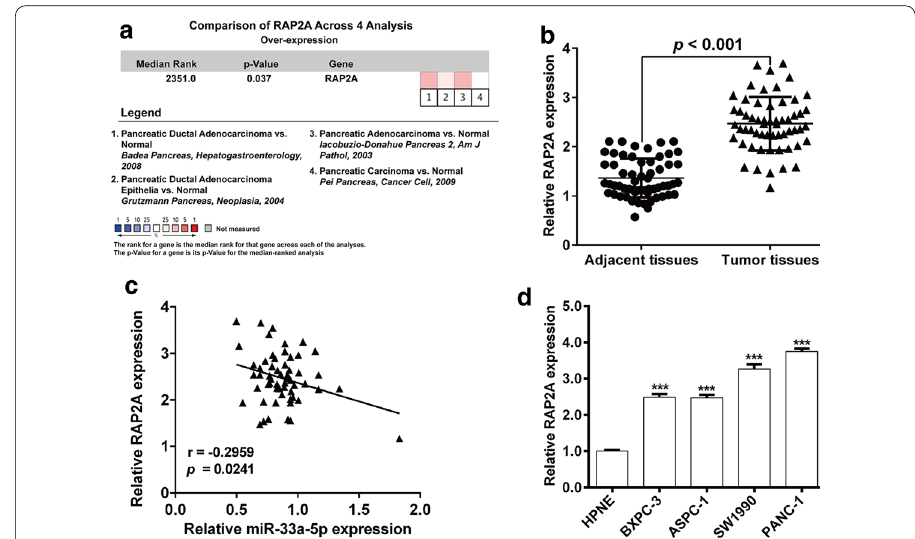
Fig. 4 RAP2A was inversely correlated with miR-33a-5p expression in PDAC. A Our meta-analysis included four microarray datasets regarding RAP2A mRNA expression in pancreatic cancer vs. normal tissues. Data are shown as the median rank of RAP2A through each dataset analysis. P -value for RAP2A was presented using the median ranked analysis for pancreatic cancer vs. normal tissues. B RAP2A mRNA levels analyzed using RT-qPCR in paired PDAC tissue samples and adjacent pancreatic tissues (n identified between miR-33a-5p and RAP2A mRNA expression levels through Spearman correlation analysis (r 0.2959, p 0.0241). (D) RAP2A mRNA levels were determined in BxPC-3, ASPC-1, SW1990, PANC-1 and = − = HPNE cell lines. *** p < 0.001 vs.